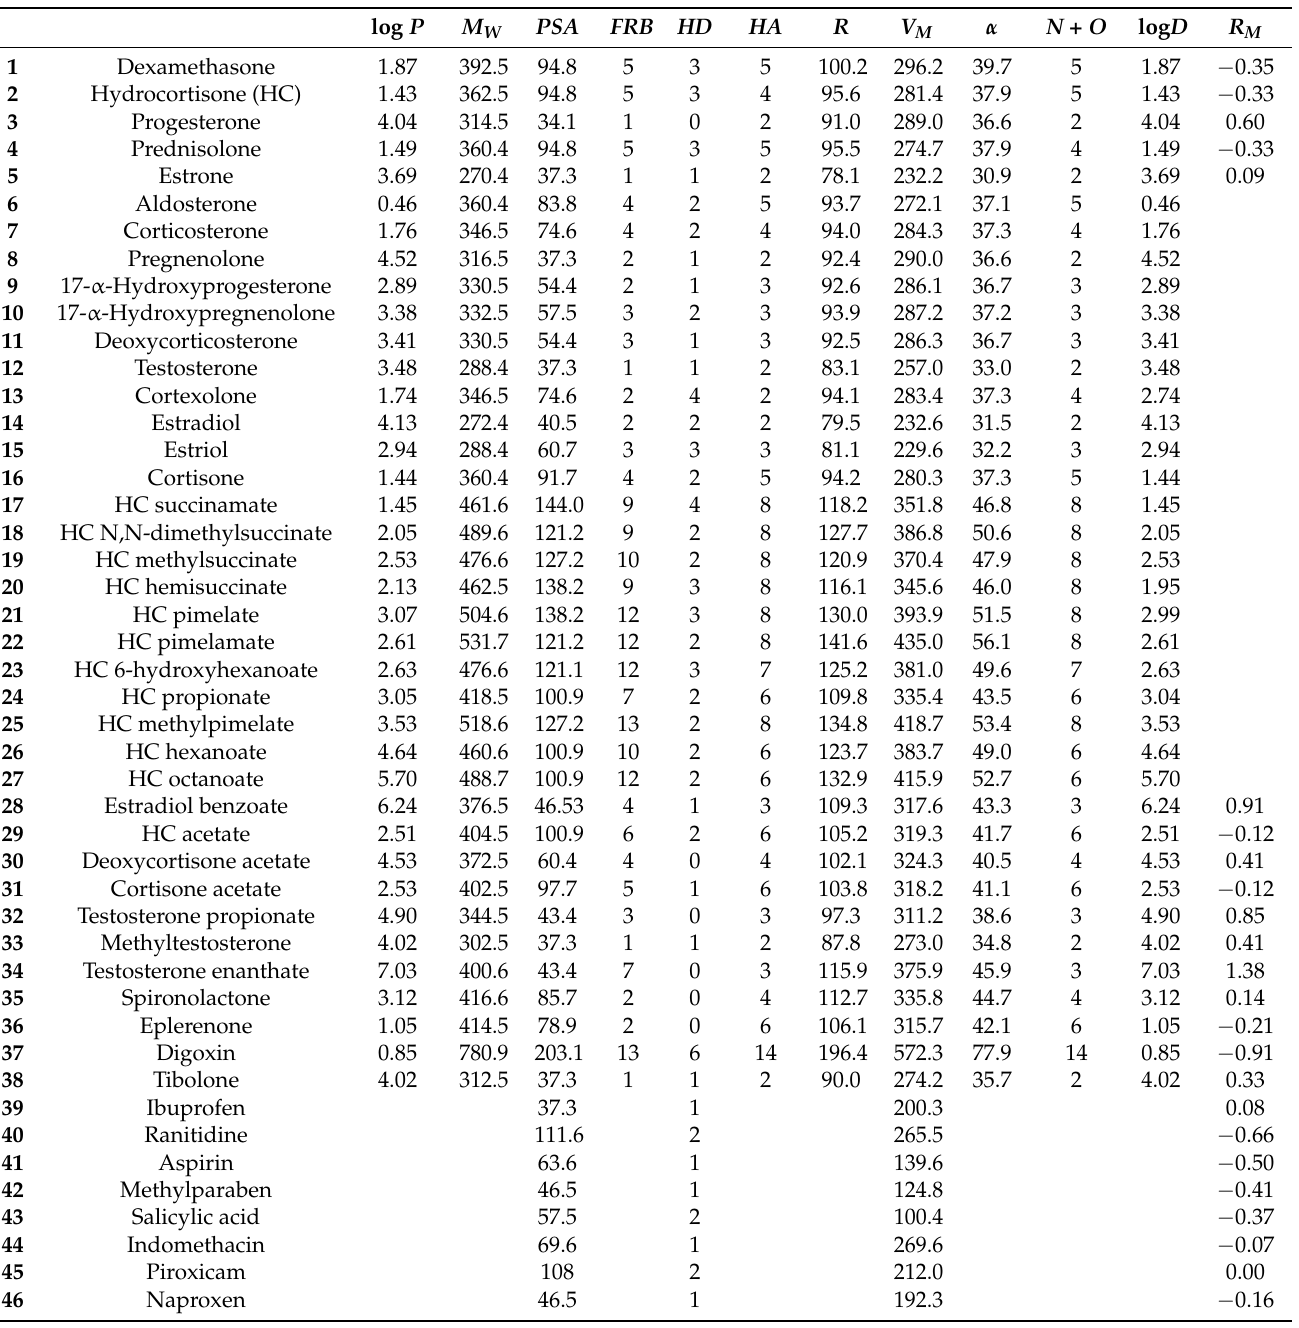
Table 2. Physicochemical and chromatographic descriptors for compounds 1 to 46